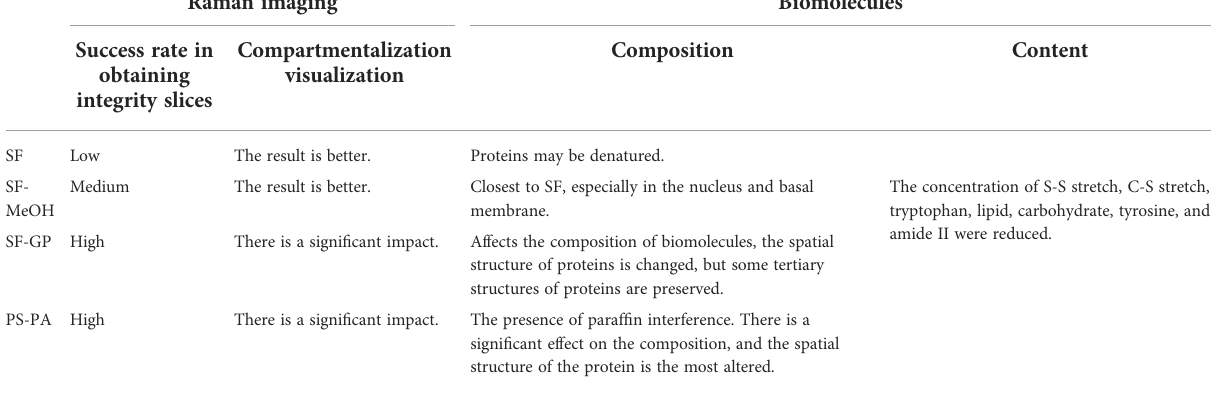
TABLE 4 Comprehensive evaluation summary of different preservation